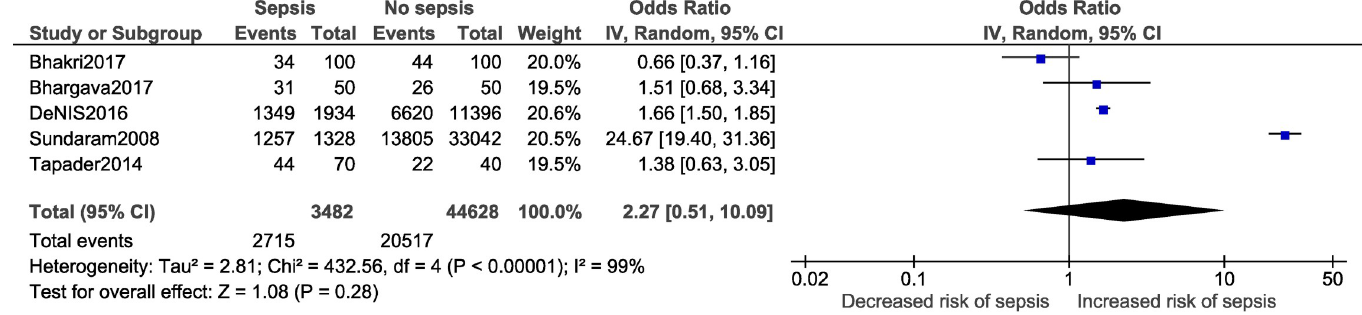
Fig 4. Forest plot showing a random-effects meta-analysis of low birth weight neonates with and without sepsis.